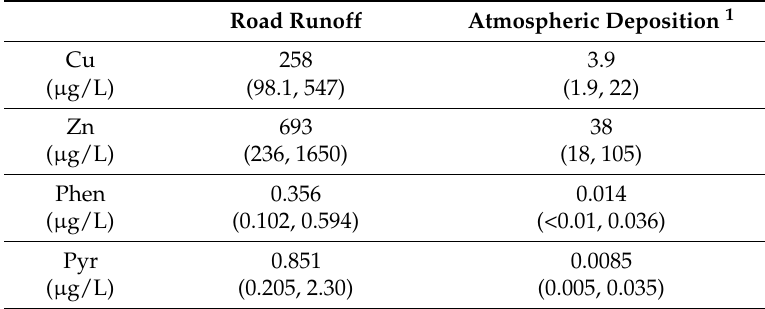
Table H1. Concentrations observed in road runoff in the present study compared to those due to atmospheric deposition. Median, minimum and maximum observed values are presented. 1 Data from [36] .